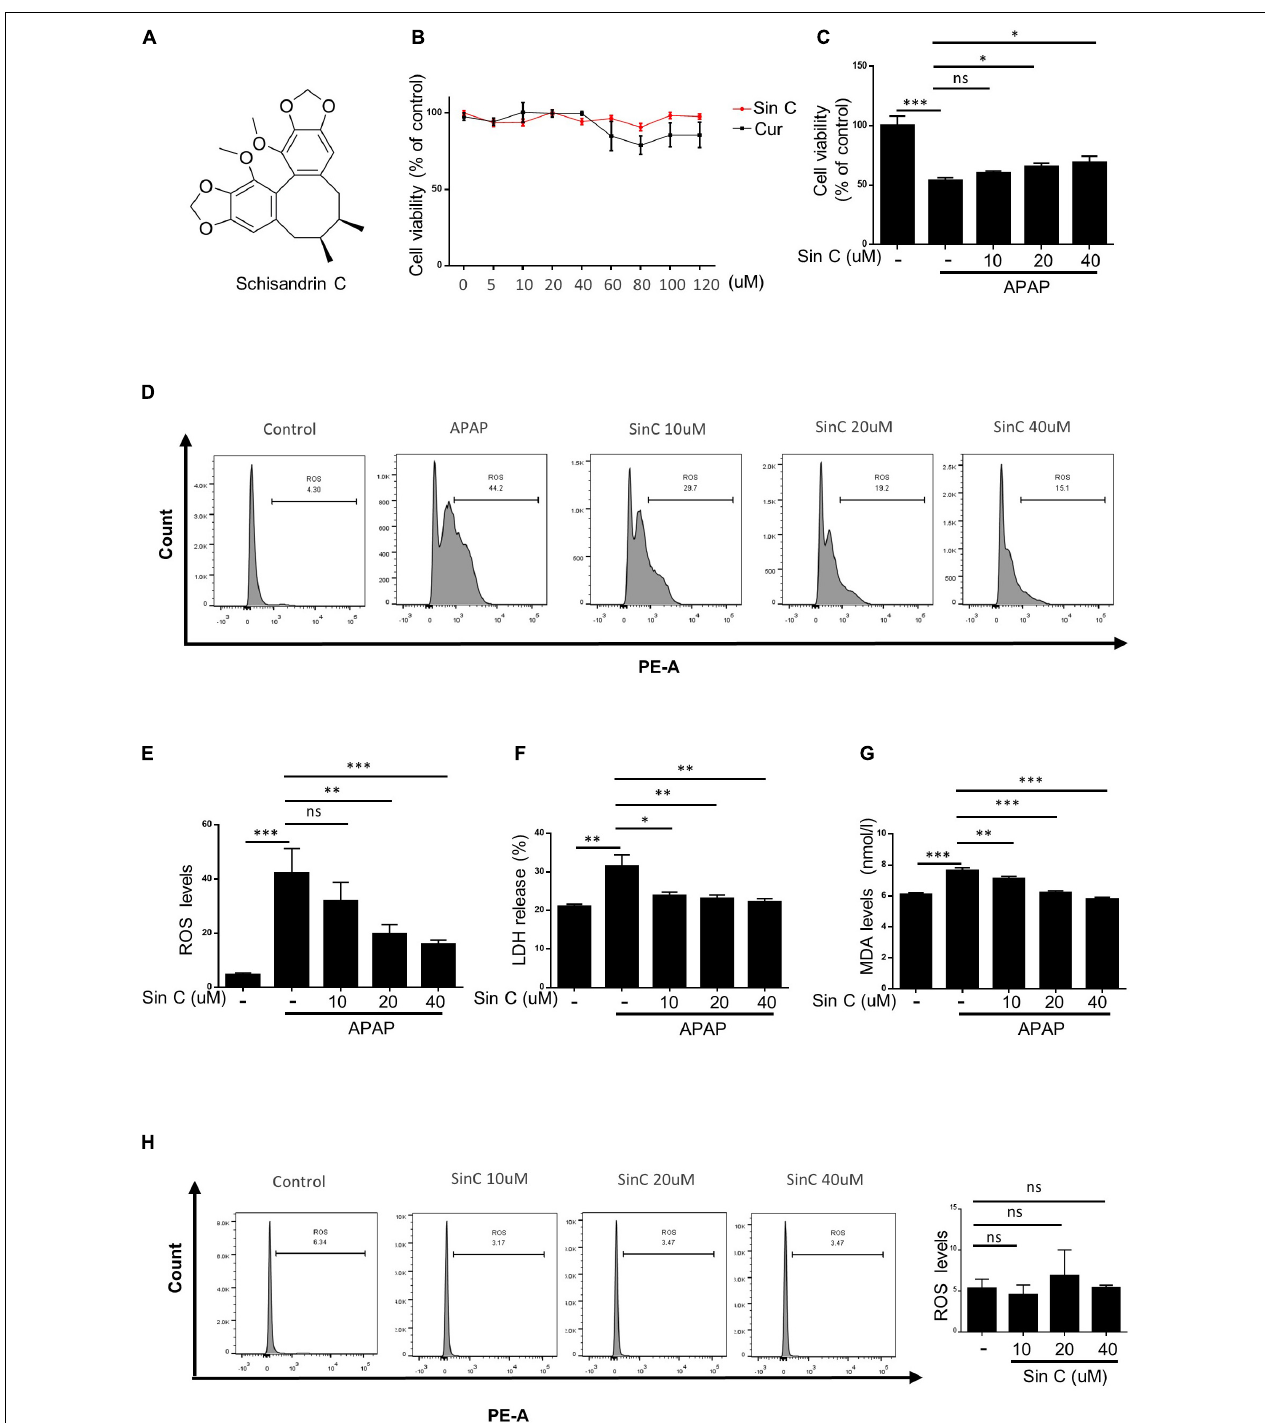
FIGURE 2 | Schisandrin (Sin C) inhibits acetaminophen (APAP)-induced oxidative stress in vitro . (A) Structure of Sin C. (B) The Cell viability of L02 cells treated with different concentrations of Sin C and Curdione was determined using CCK-8 kit. (C–G) L02 cells were pretreated with SinC (10, 20, and 40 µ M) for 6 h and then exposed to APAP (20 mM) for a further 12 h. The survival rate by CCK-8 (C) and the release of LDH (D) and MDA (E) were detected. (F–G) The percentage of reactive oxygen species (ROS) positive cells were detected with MitoSox staining and analyzed by FACS. (H) L02 cells were treated with SinC (10, 20, and 40 µ M) for 18 h without any treatment and the percentage of ROS positive cells were detected with MitoSox staining and analyzed by FACS. Data are expressed as the mean ± SD of three independent experiments, * p < 0.05, ** p < 0.01, and *** p < 0.001; ns, not significant.